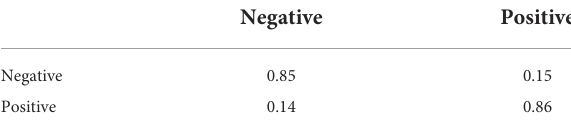
TABLE 8 2-Class sentiment classification confusion matrix (Flat-OCC).